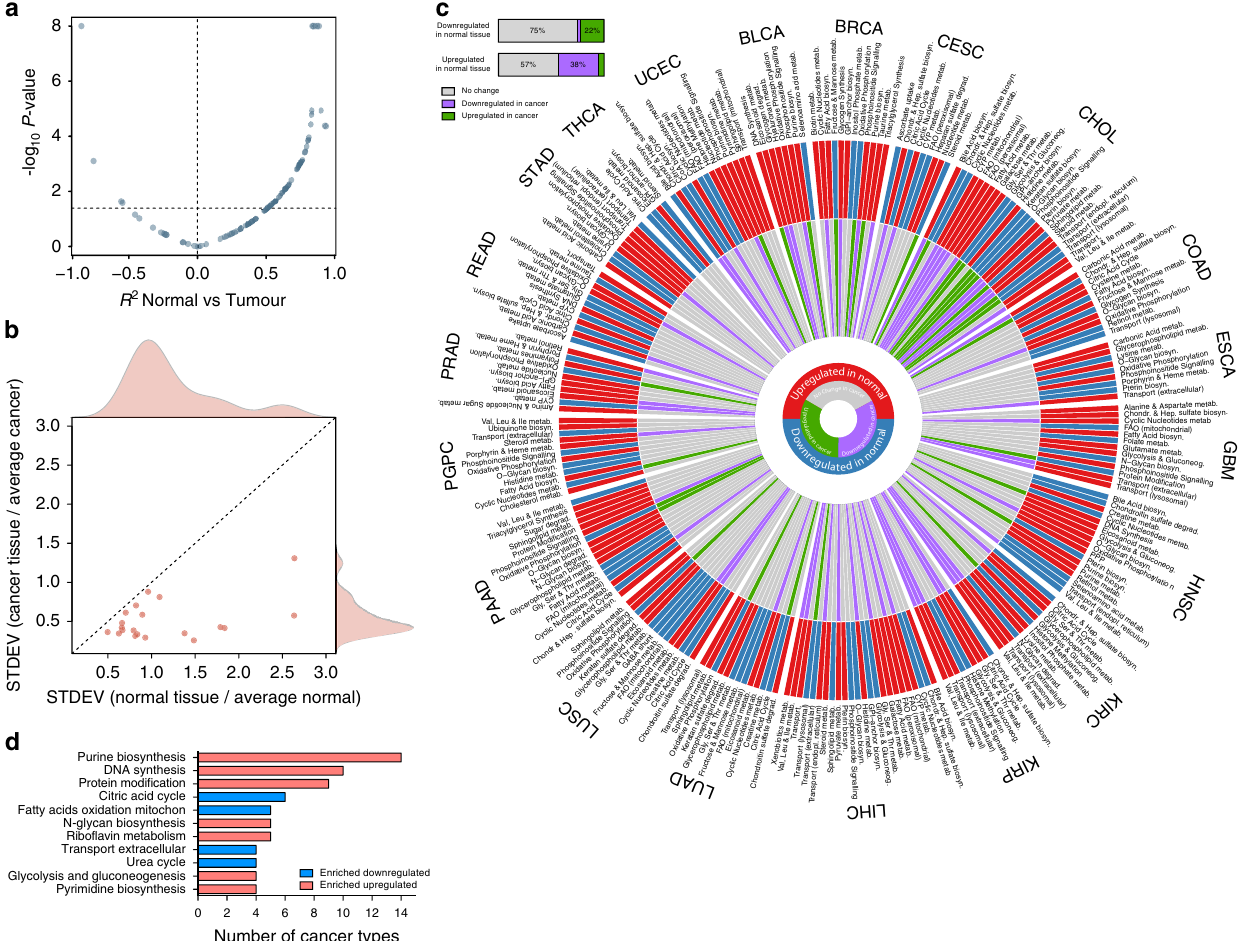
Figure 2 | The metabolic landscape of cancer is tissue-specific but convergent. ( a ) Scatter plot representation of correlation coefficient (Spearman, x axis) and correlation P -value ( (cid:2) log 10 , y axis) of metabolic pathways in normal tissue compared to cancer. Horizontal dashed line indicates FDR of 5% ( (cid:2) log 10 ). ( b ) Scatter plot representation of the variance of metabolic pathways among normal ( x axis) and cancer ( y axis) tissues. ( c ) Tissue-specific metabolic signatures in normal and cancer tissues are represented in a polar histogram. The external circle displays metabolic pathways found enriched upregulated (red) or downregulated (blue) in normal tissues, compared to average. The internal circle shows the enrichment of individual metabolic pathways in cancer compared to normal. Grey bars indicate no change in cancer compared to normal. The horizontal histogram indicates the proportion of metabolic pathways altered in cancer compared to pathways downregulated or upregulated in normal tissues. ( d ) Metabolic pathways enriched in cancer tissue compared to normal, independent of tissue of origin. Metabolic pathways enriched in 4 20% of cancer types are shown. NATURE COMMUNICATIONS|7:13041|DOI: